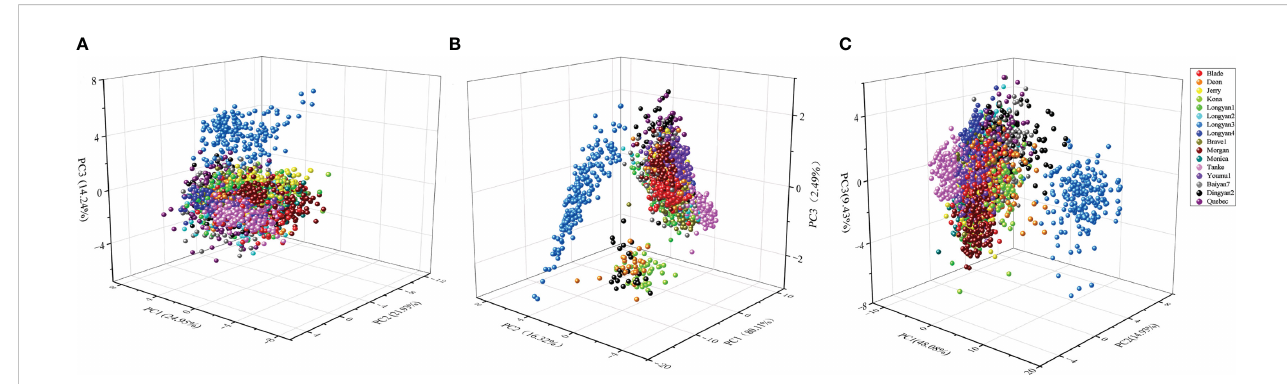
FIGURE 6 Three-dimensional plot of the fi rst three principal components (PCs) for (A) morphological, (B) spectral and (C) morphological combined with spectral features dataset in 16